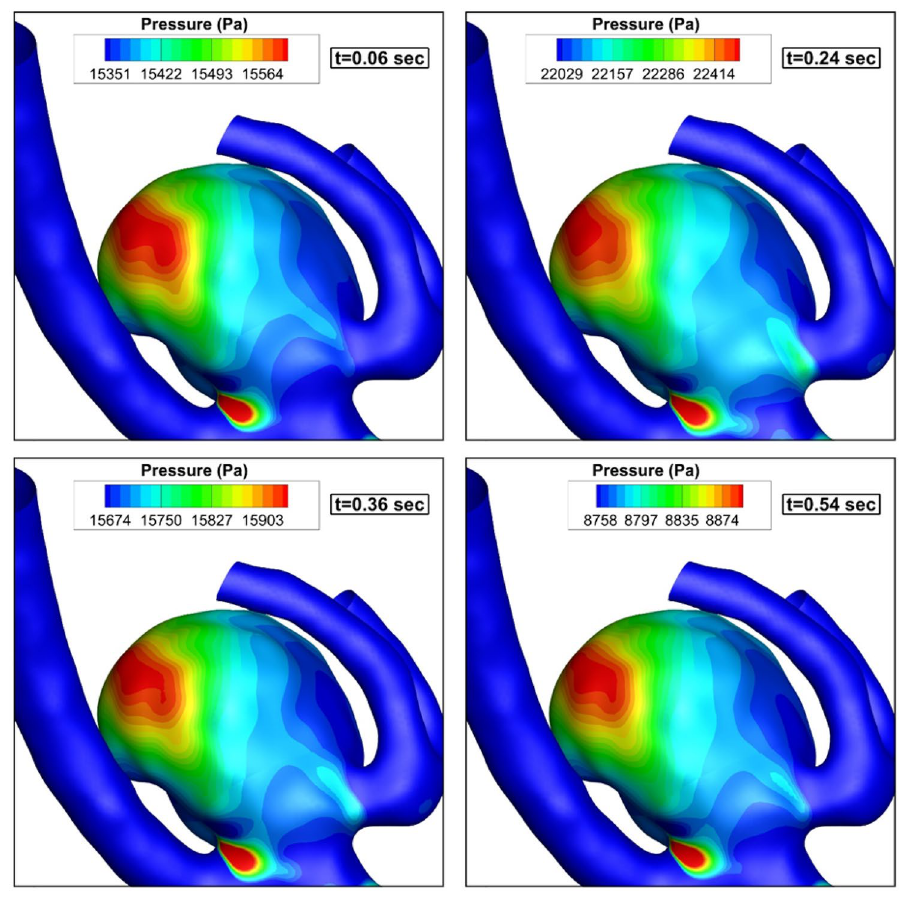
Figure 4. Pressure contour (hct = 0.40 without coiling (porosity =